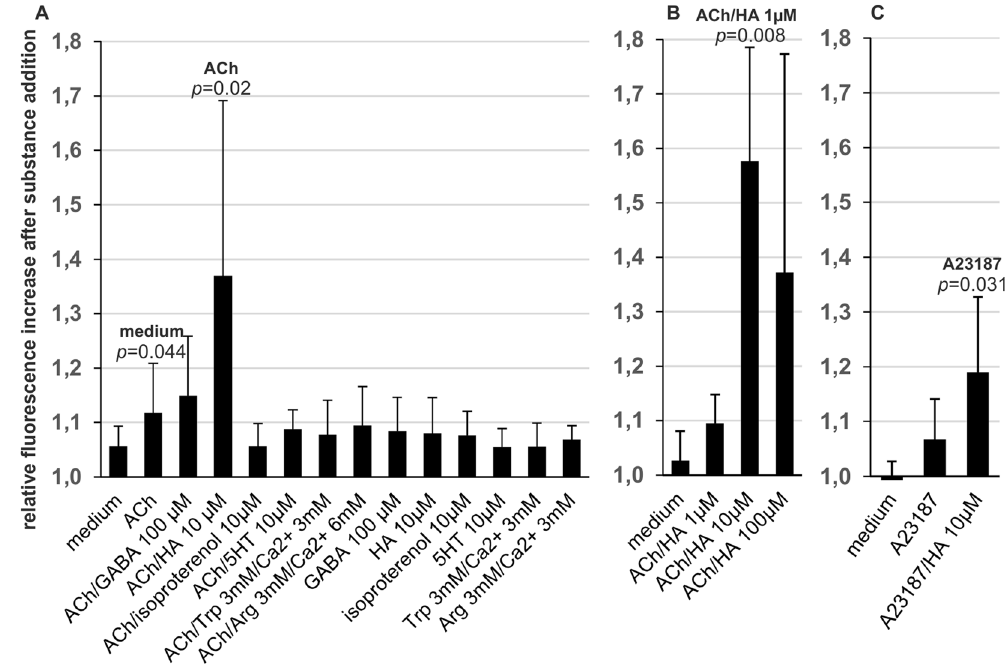
Figure 4. Screening for putative activators or inhibitors of the [Ca 2 + ] i response to ACh and the Ca 2 + ionophor A23187. Fluorescence enhancement was measured 10 s after addition of 200 µ l medium containing ACh or A23187 (final concentrations 1 and 0.1 µ M, respectively) and the putative activating/inhibiting substance in relation to baseline fluorescence. Final substance concentrations are indicated. Statistical significance compared to the treatment group indicated on top of the bar was calculated by univariate analysis with the Mann-Whitney U -test. ( A ) Screening test (see explanation in Methods ) for P-STS activation by putative activators/inhibitors of [Ca 2 + ] i response to ACh (age of culture 10 months). Mean values and standard deviations were calculated from 6–14 independent samples. ( B ) Dependence of the [Ca 2 + ] i response to ACh on HA concentration (age of culture > 1 year). Mean values and standard deviations were calculated from 5 experiments testing. ( C ) Influence of 10 µ M HA on the [Ca 2 + ] i rise caused by A23187 (age of culture > 1 year). Mean values and standard deviations were calculated from 9